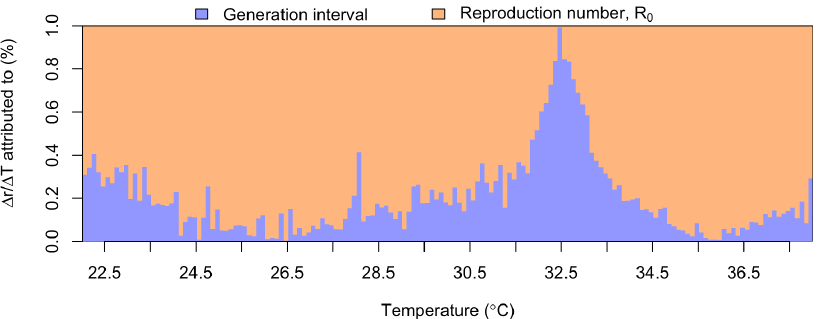
Fig 4. Relative contributions of the generation interval (blue) and the basic reproduction number R 0 (orange) to temperature-driven changes in epidemic growth rate r . Temperature changes are considered in 0.1˚C increments and assume λ = 0.2. See S1 Fig for consideration of alternative λ